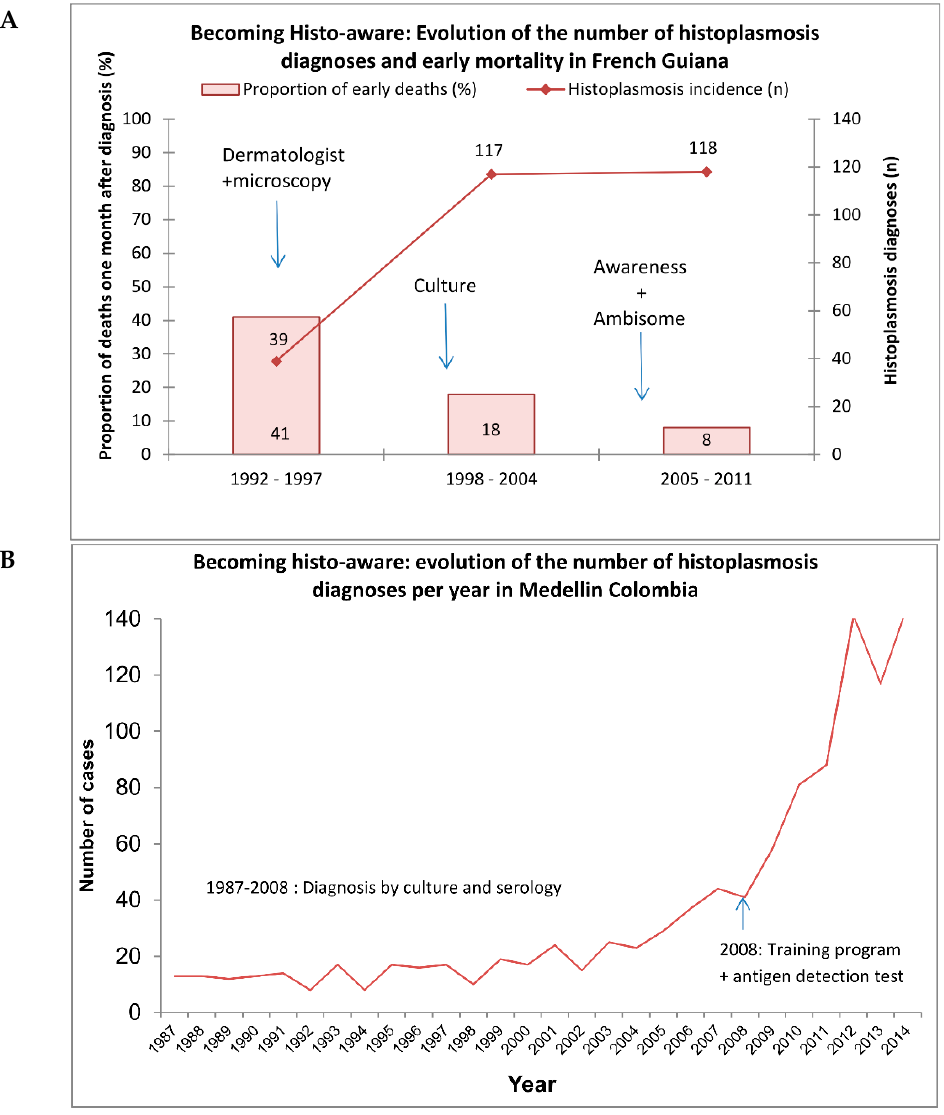
Figure 1. Becoming histoplasmosis-aware (“histo-aware”) in ( a ) French Guiana and ( b ) Colombia. In Fortaleza, Brazil, in the early 1980s, visceral leishmaniasis was already a well-known endemic disease, and histoplasmosis was considered a rare event. Coincidentally with the beginning of the AIDS epidemic in Fortaleza, the first cases of disseminated histoplasmosis (DH) were “accidentally” diagnosed when buffy coat was used to look for Leishmania in the peripheral blood of patients with presentations compatible with Kala-azar. A microbiologist (Jacó Ricarte L.